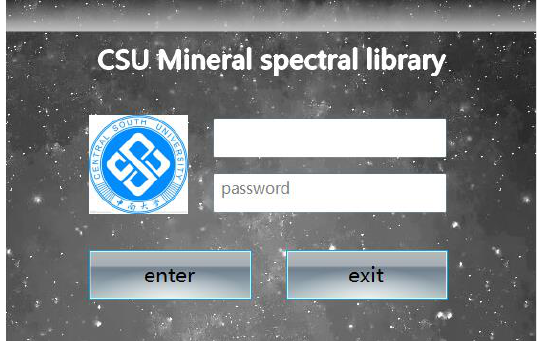
Figure 8. Interface of login to the integrated MSL